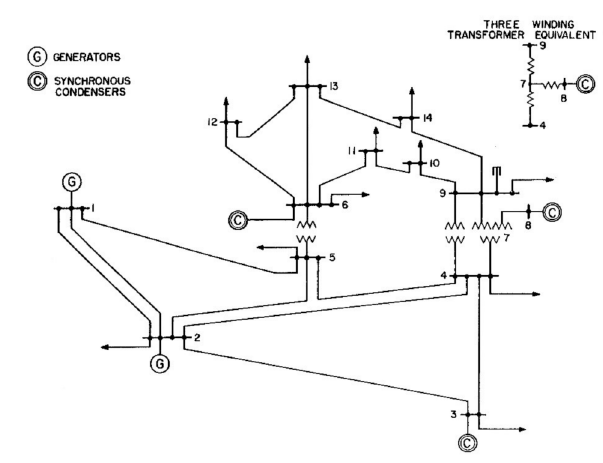
Figure 6. The used test system.